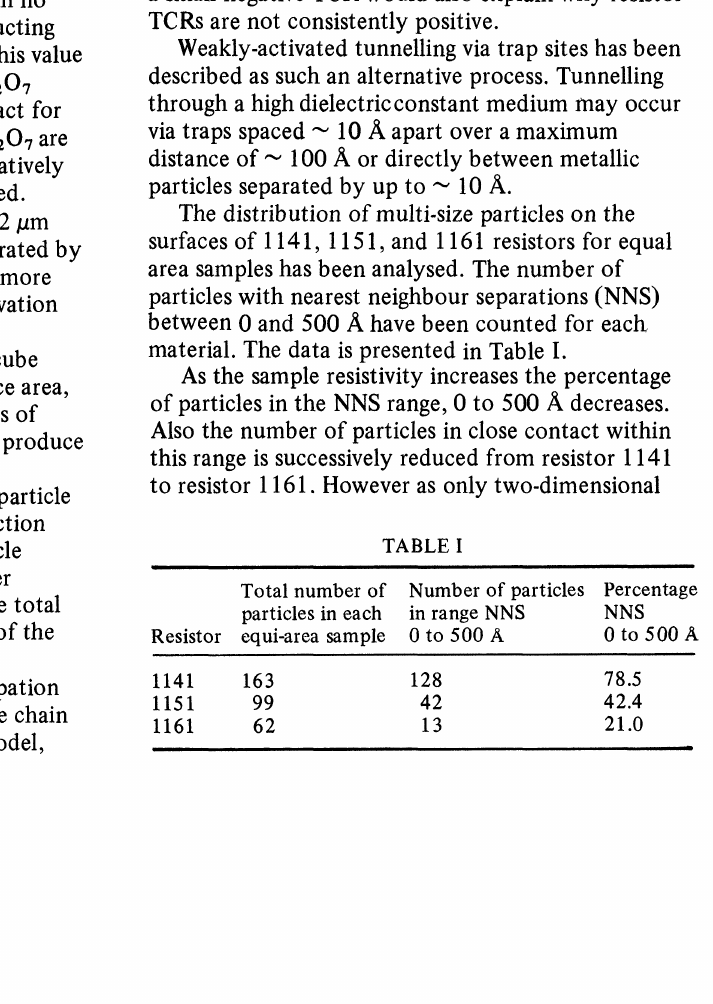
Total number of Number of particles Percentage particles in each in range NNS NNS Resistor equi-area sample 0 to 500